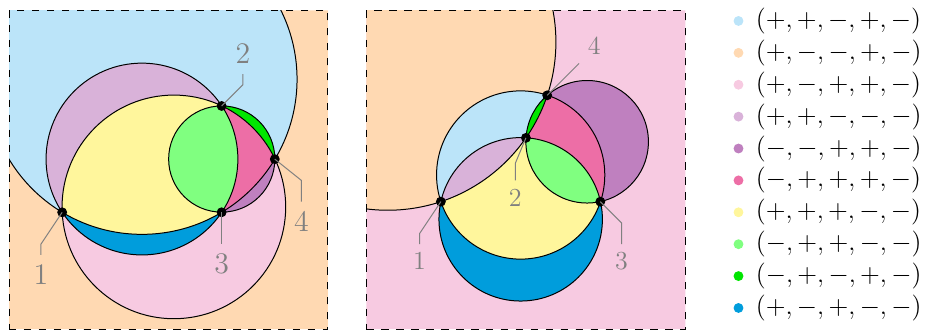
Figure 5 . Tiling of the celestial sphere for n = 5 , holding { z 1 , z 2 , z 3 , z 4 } fixed in two different puncture configurations, together with the corresponding channel labels ~(cid:15)/ Z 2